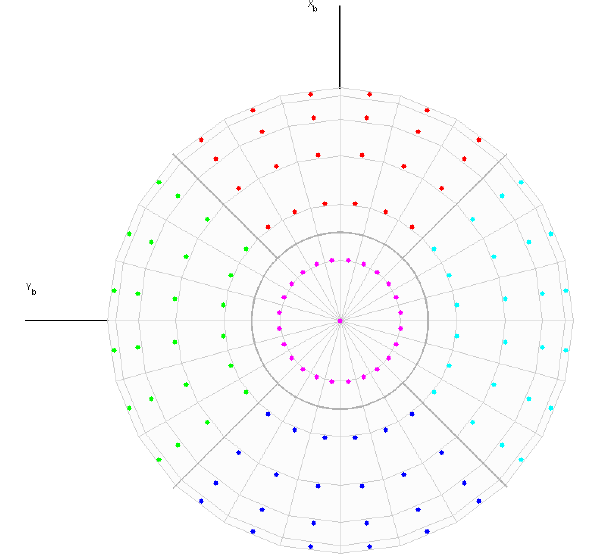
Figure 31: South Pole (bottom) view of the hemispherical micro- phone grid used for the Directional